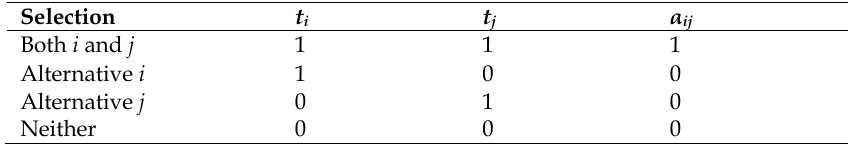
Table 1. Values of variable α